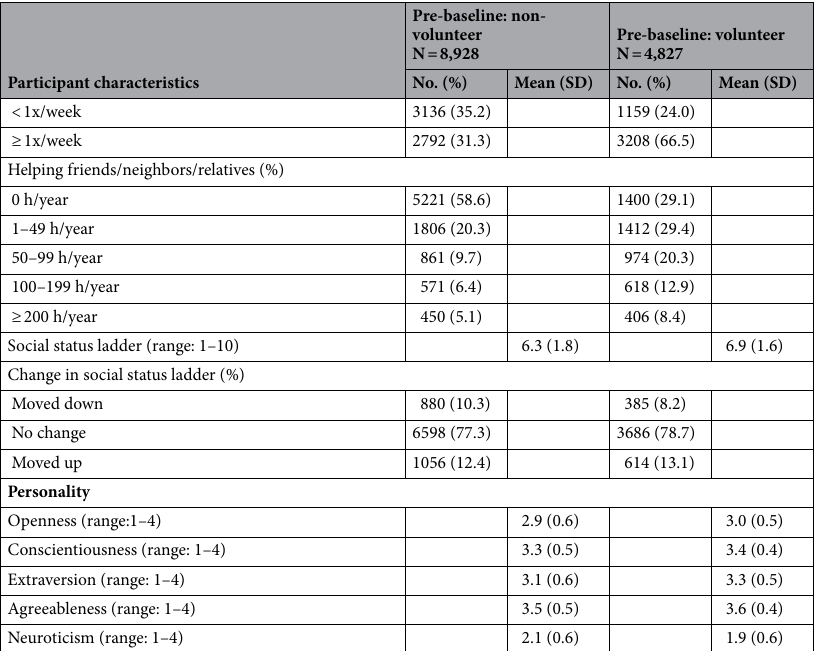
Table 1. Characteristics of participants at pre-baseline (N = 13,755) a,b,c . a This table was created based on non-imputed data. b All variables in Table 1 were used as covariates, and assessed in the pre-baseline wave (t 0 ; 2006/2008). c The percentages in some sections may not add up to 100% due to